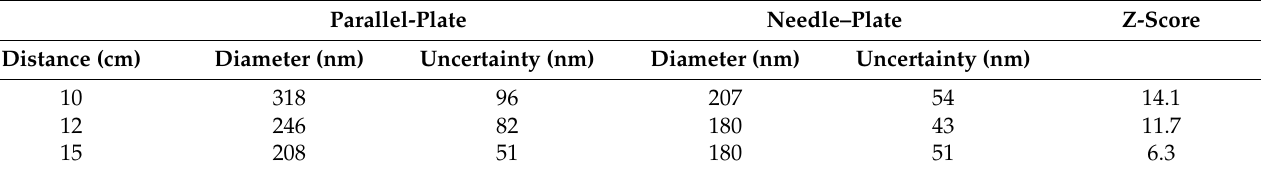
Figure 9. The 10,000x magnification of electrospun fibers from deposit 2. Figure 10. The 10,000x magnification of electrospun fibers from deposit 3.